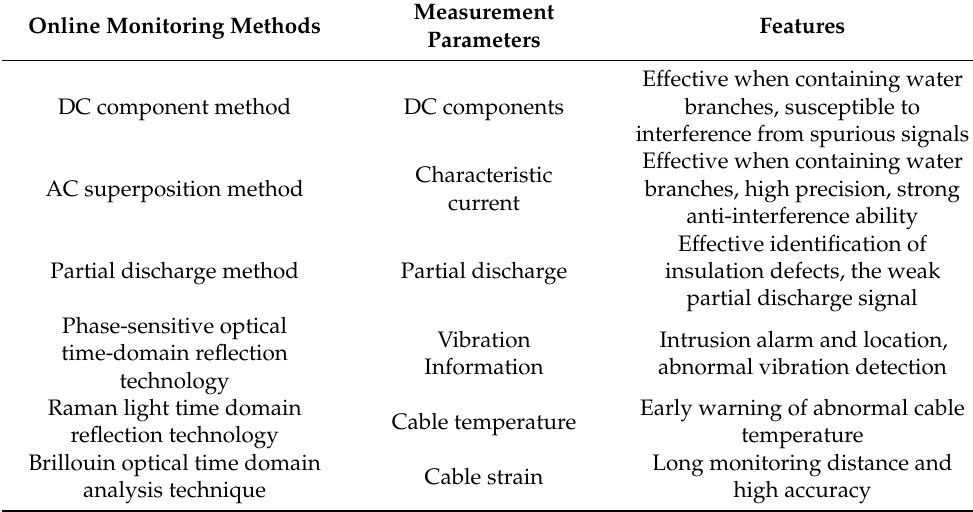
Table 1. Cable online monitoring technology